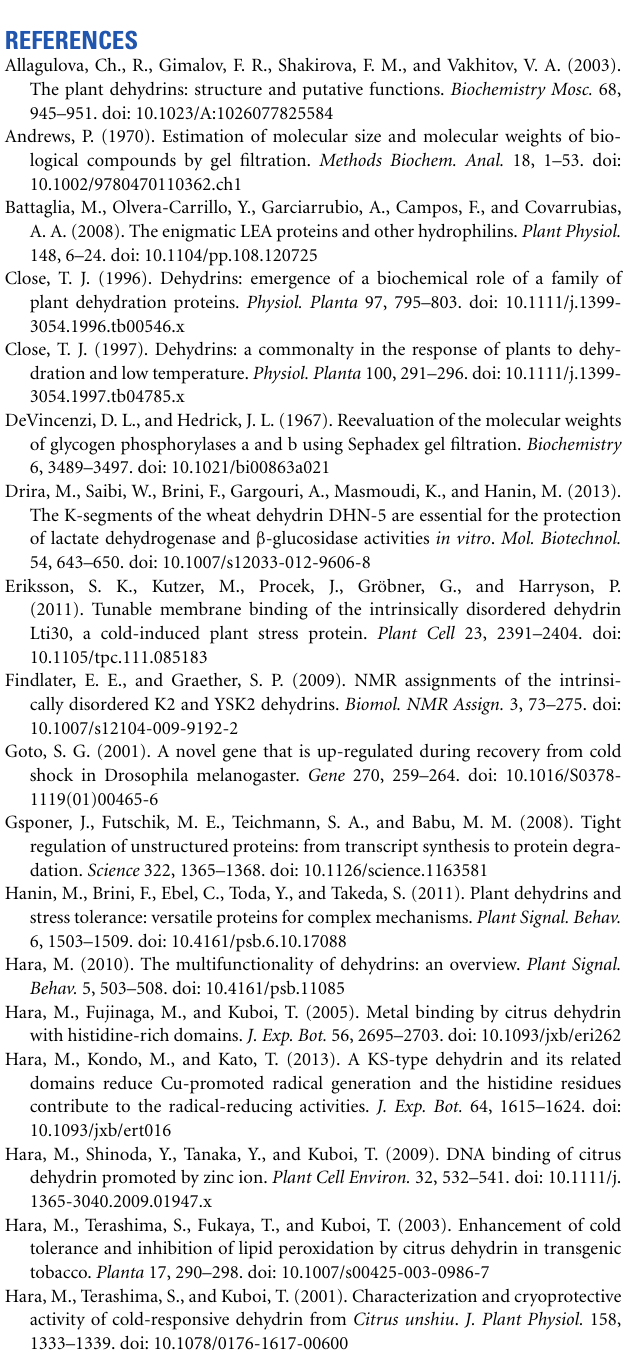
Supplemental Figure 3 | OpsDHN1 protein contains 19 histidines. yellow throughout the